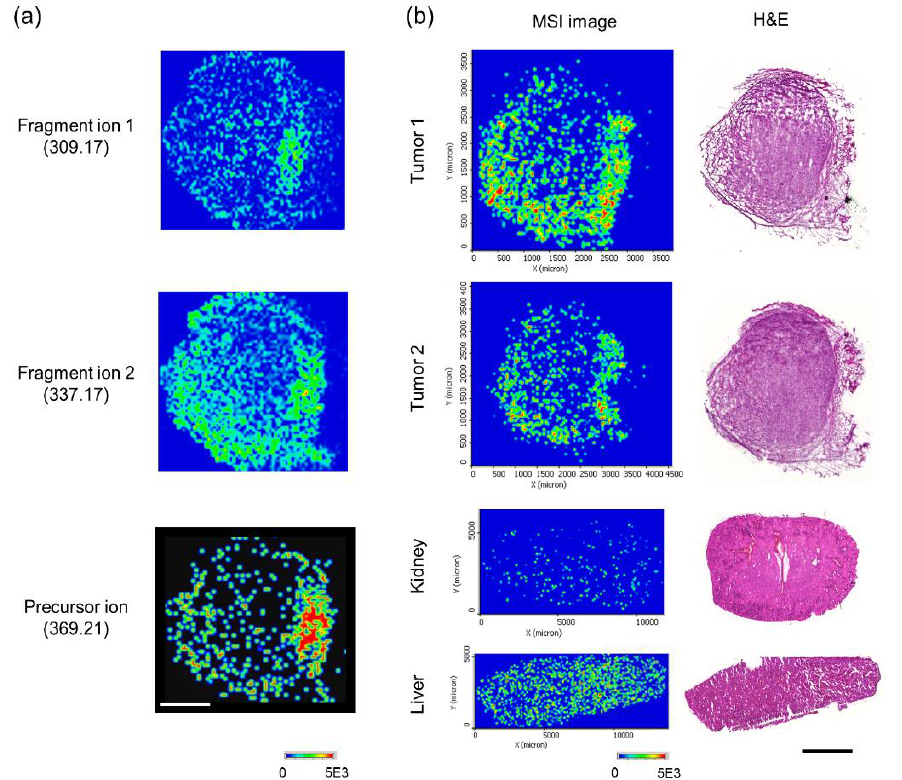
Figure 5. Identification of voacangine in tissue sections using mass spectrometry imaging (MSI). ( a ) MALDI-MSI signal for voacangine (precursor ion, fragment ion 1, and fragment ion 2) from voacangine-treated tumor tissue. The results shown are representative of three independent experiments. Scale bar, 1 mm. ( b ) Comparison of voacangine MSI (the precursor ion) between other voacangine-treated tumors and organ tissues (kidney and liver).